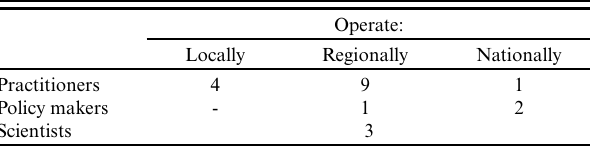
Table 2 . Role and distribution of interview participants.